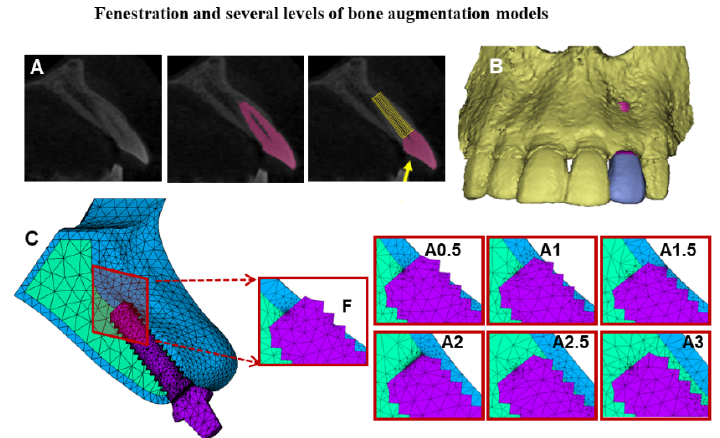
Figure 1. The anterior maxillary bone segment with implant and abutment models. ( A ): The sagittal section of the lateral incisor tooth and implant inserted at the same direction of the tooth root; the yellow arrow indicates the applied force direction. ( B ): The three-dimensional CBCT based model of the anterior maxillary bone segment with facial bone fenestration defect. ( C ): Meshed fenestration model and simulation of several levels of bone augmentation of the facial bone defect are displayed in the cross-sectional images (F): Fenestration model, (A0.5–A3.0): Augmentation models with 0.5 mm